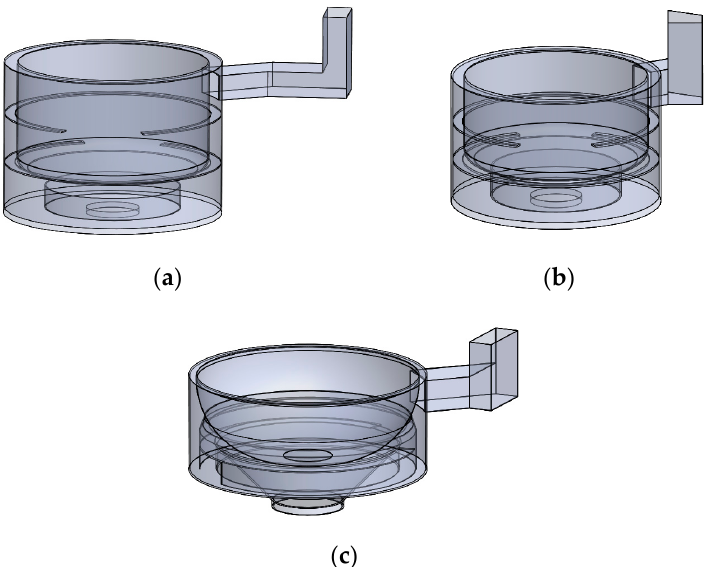
Figure 2. The 3D models of stove chambers: ( a ) staple food stove A; ( b ) staple food stove B; ( c ) subsidiary food stove C.